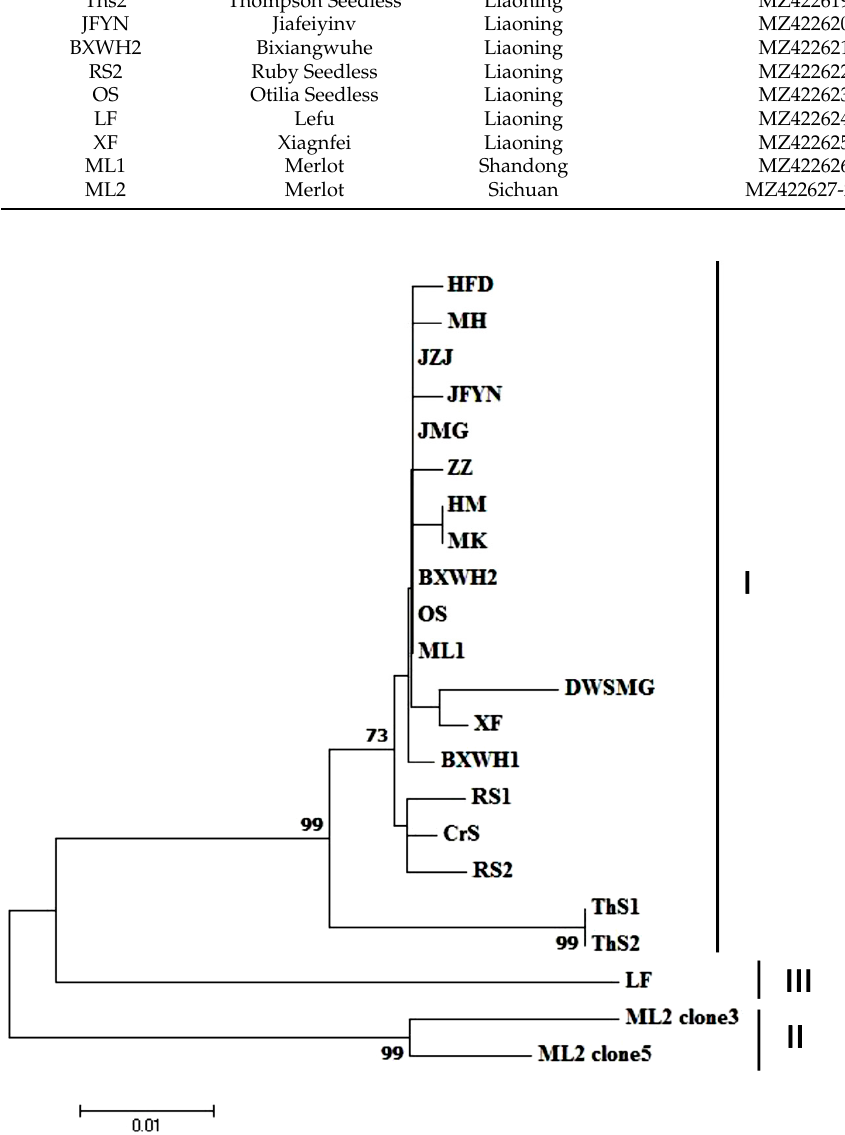
Figure 4. Neighbor-joining phylogenetic tree generated using CP gene sequences of grapevine-associated marafivirus (GaMV)